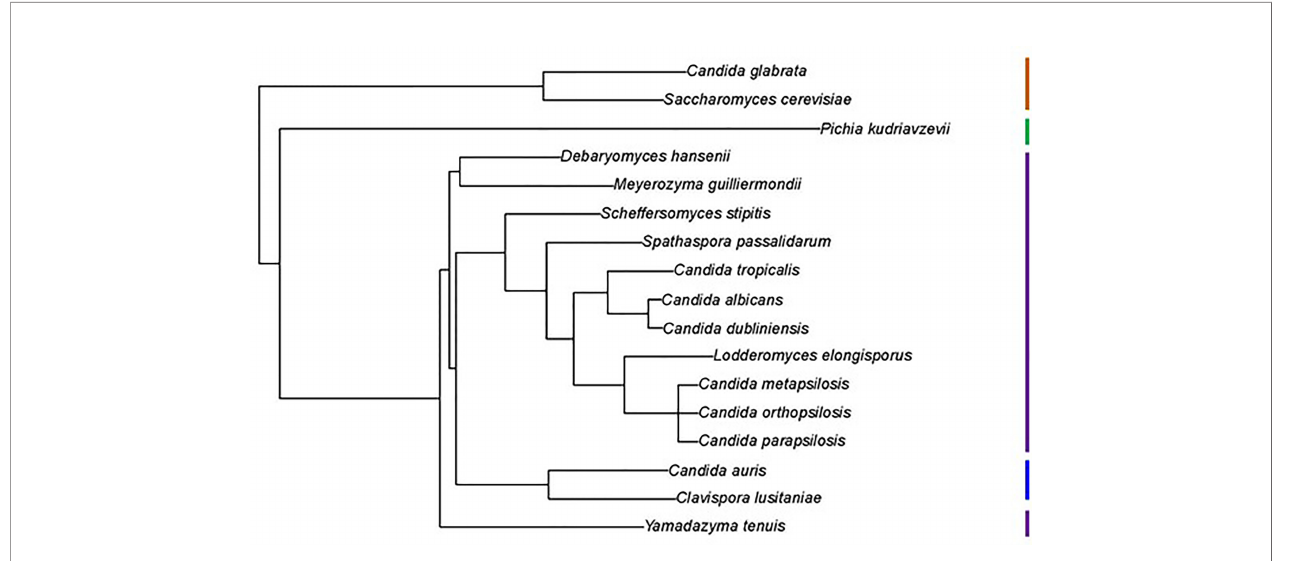
FIGURE 1 | Phylogenetic tree showing relationships between fungal species used in this study. The tree was pruned from the genome-scale phylogeny of the kingdom Fungi developed by Li et al. (2021). The phylogeny was based on 290 concatenated sequences in 1644 species. C. metapsilosis was not part of the original analysis and was added to the tree based on its close relationship with C. parapsilosis and C. orthopsilosis (Tavanti et al., 2005). All species listed were Phylum Ascomycota, Subphylum Saccharomycotina, Class Saccharomycetes, Order Saccharomycetales. Vertical bars on the right of the image indicate Family designations according to the NCBI Taxonomy Database (https://www.ncbi.nlm.nih.gov/taxonomy). Brown = Family Saccharomycetaceae , Green = Family Pichiaceae , Purple = Family Debaryomycetaceae , and Blue = Family Metschnikowiaceae